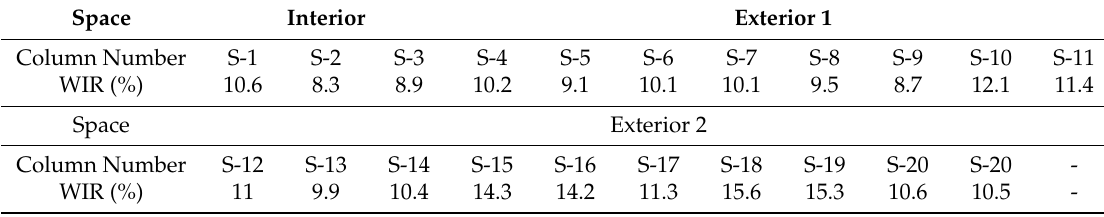
Table 9. Sample results in the water inclusion ratio (WIR) for the target Hanok (B-3) on 7 June 2018.